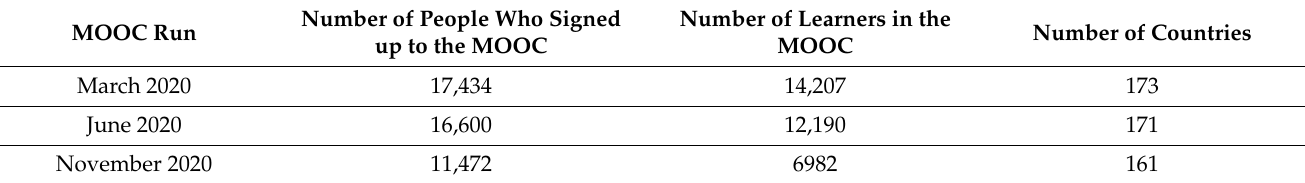
Table A2. MOOC participants.